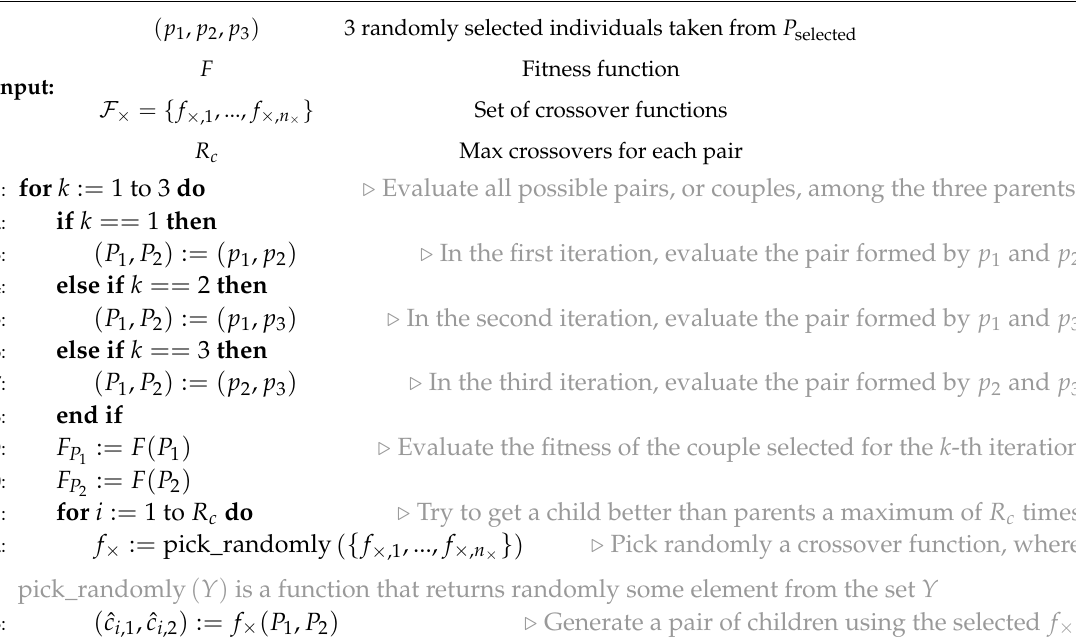
Algorithm 1 Proposed multi-crossover